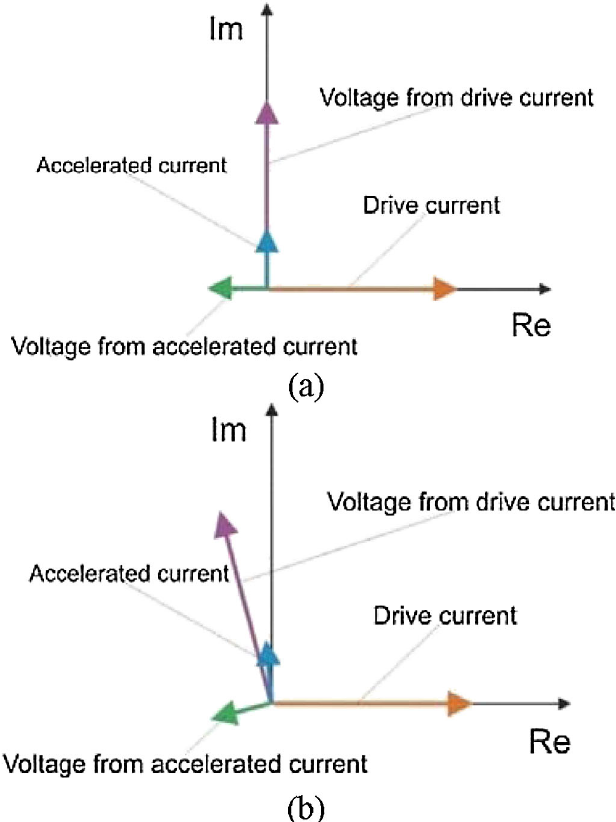
FIG. 8. (Color) (a) Exciting a detuned cavity without loss. (b) Exciting a detuned cavity with loss. Excitation off resonance allows a transformer ratio greater than